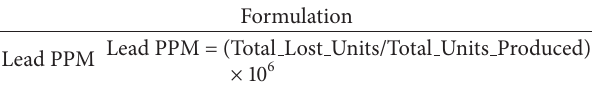
Table 9: Lead ppm for performance measures. Formulation